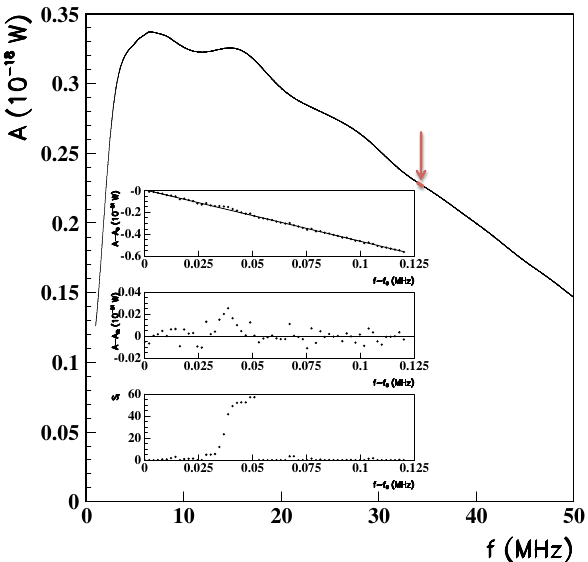
Fig. 7 The power spectrum to be analyzed. The data are from a test setup for an axion search experiment developed at the Max Planck Institute for Physics. A signal corresponding to a possible axion signal was introduced in the setup and searched for using the test statistic described in this paper. The arrow shows the location where the signal was injected. The region of the signal is shown in the inset together with the background fit (top inset), the residuals from the fit (middle inset) and the run χ 2 (lower inset)